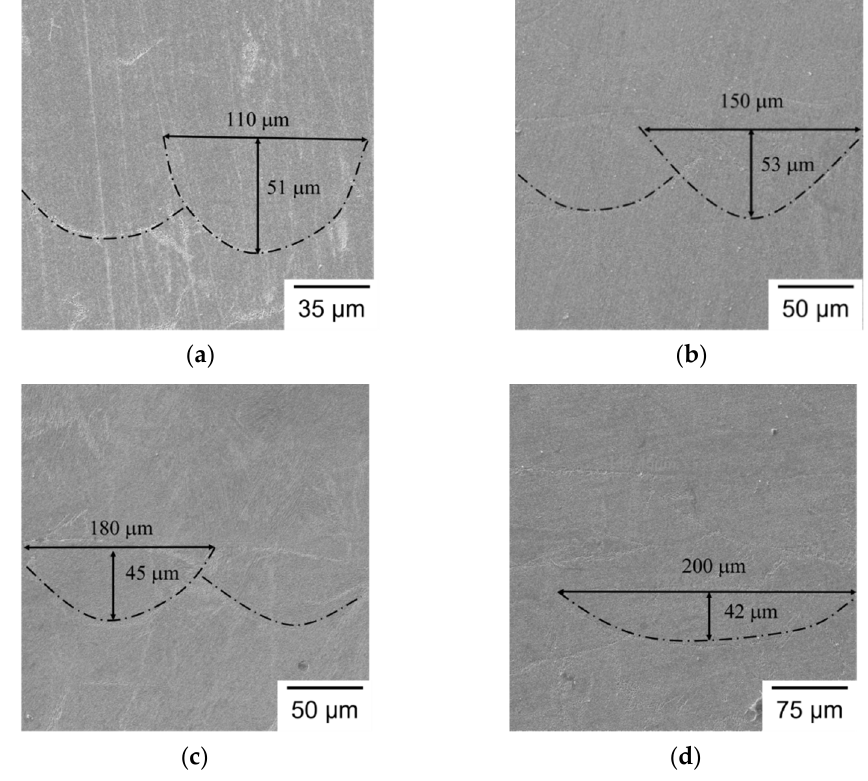
Figure 8. SEM micrographs of melt pool: ( a ) S1; ( b ) S2; ( c ) S3; ( d ) S4.